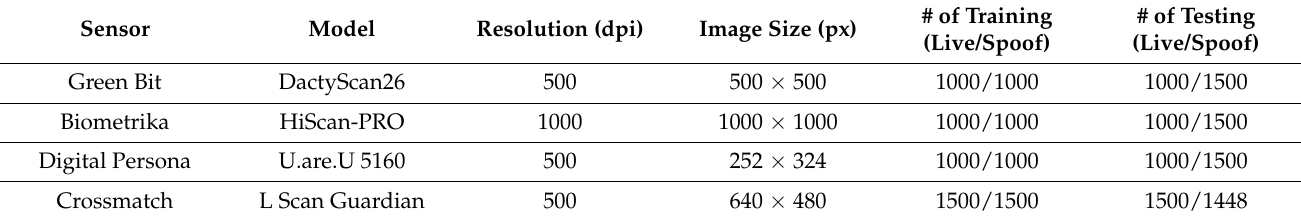
Table 1. Summary of LivDet2015 datasets used in the experiments.